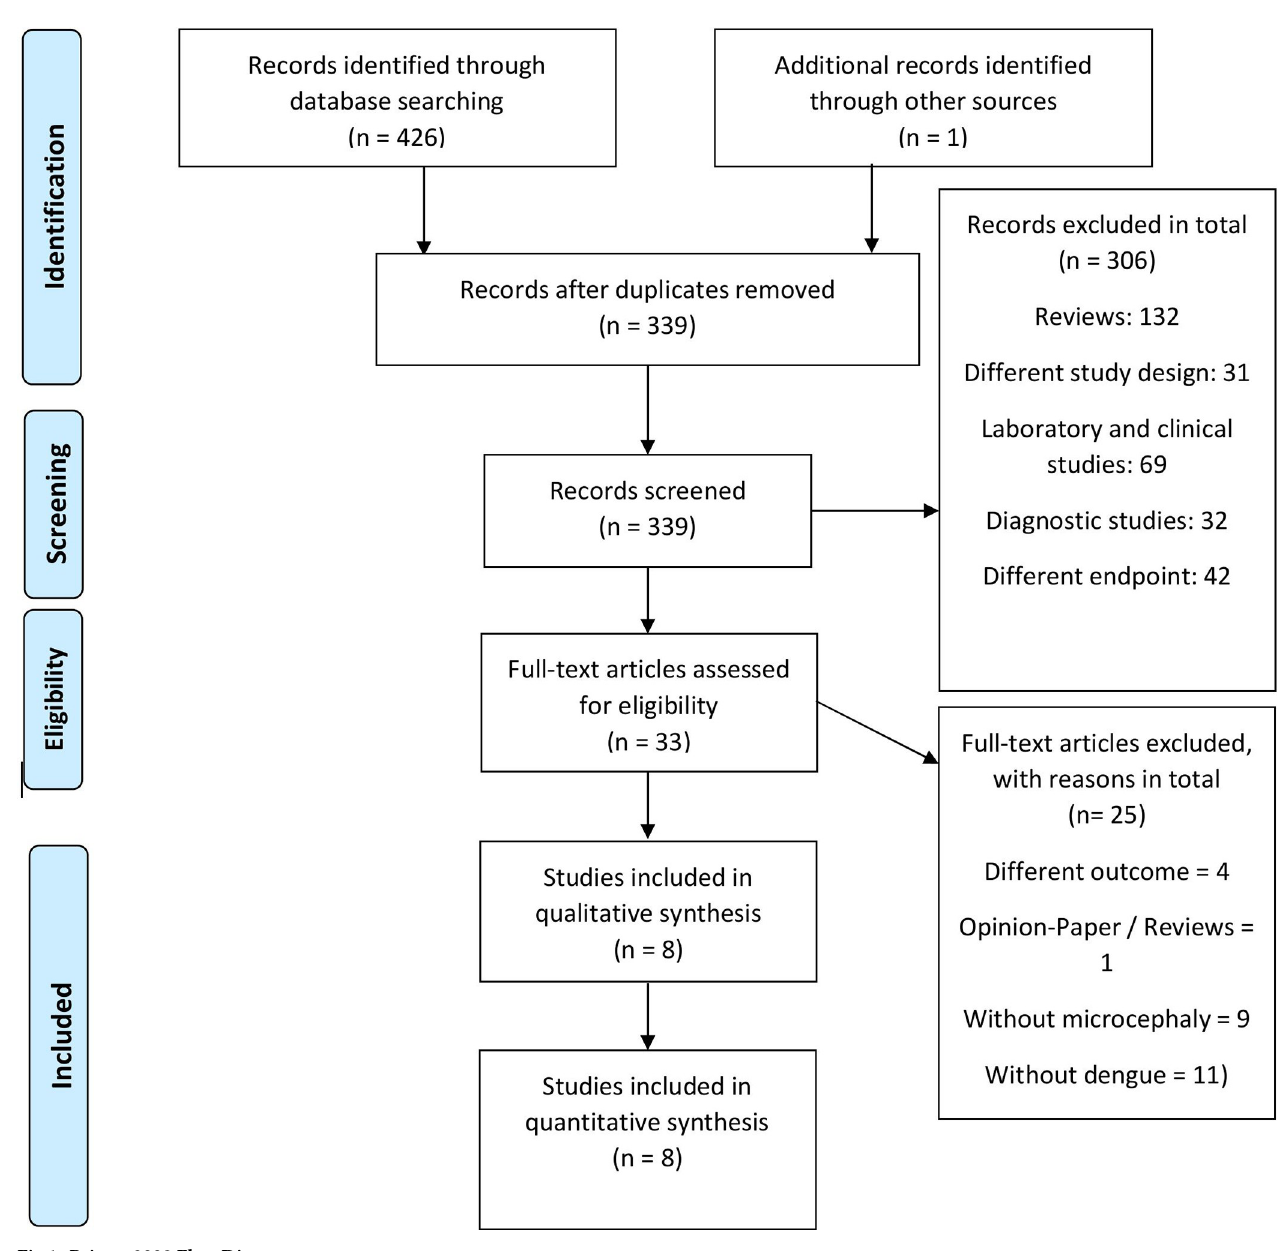
Fig 1. Prisma 2009 Flow